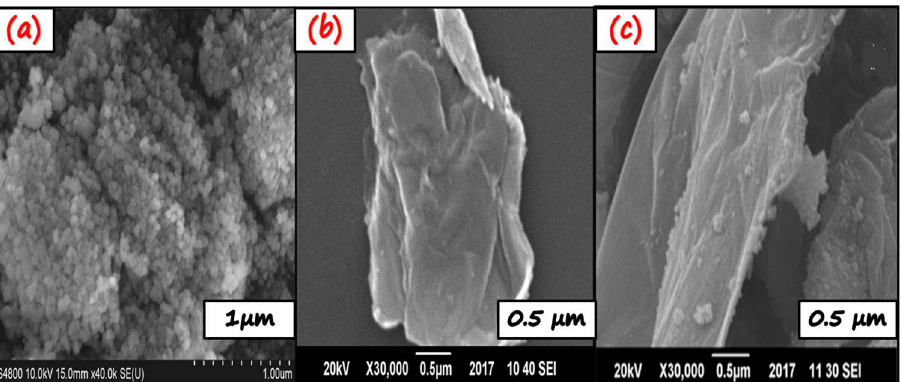
Figure 1. The XRD patterns.